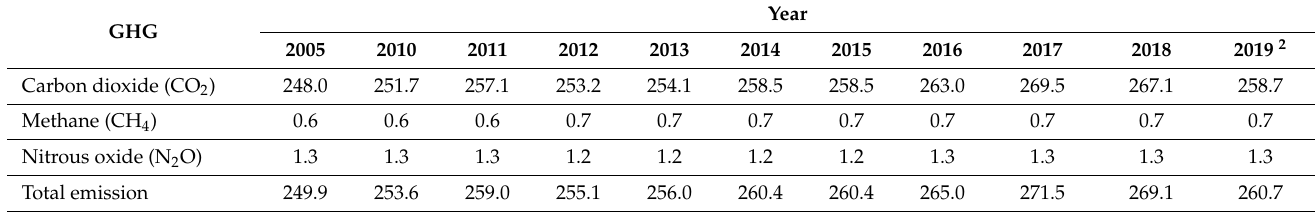
Table 5. Taiwan’s GHG emissions from the energy sector since 2005 1 . GHG